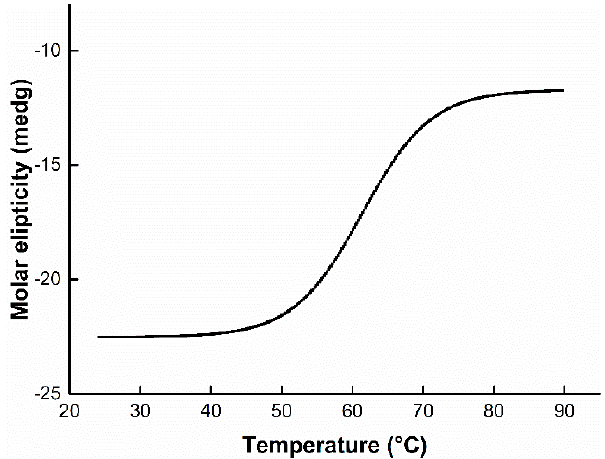
Figure 4. Thermal deformation curve at temperatures ranging from 25 to 90 °C.